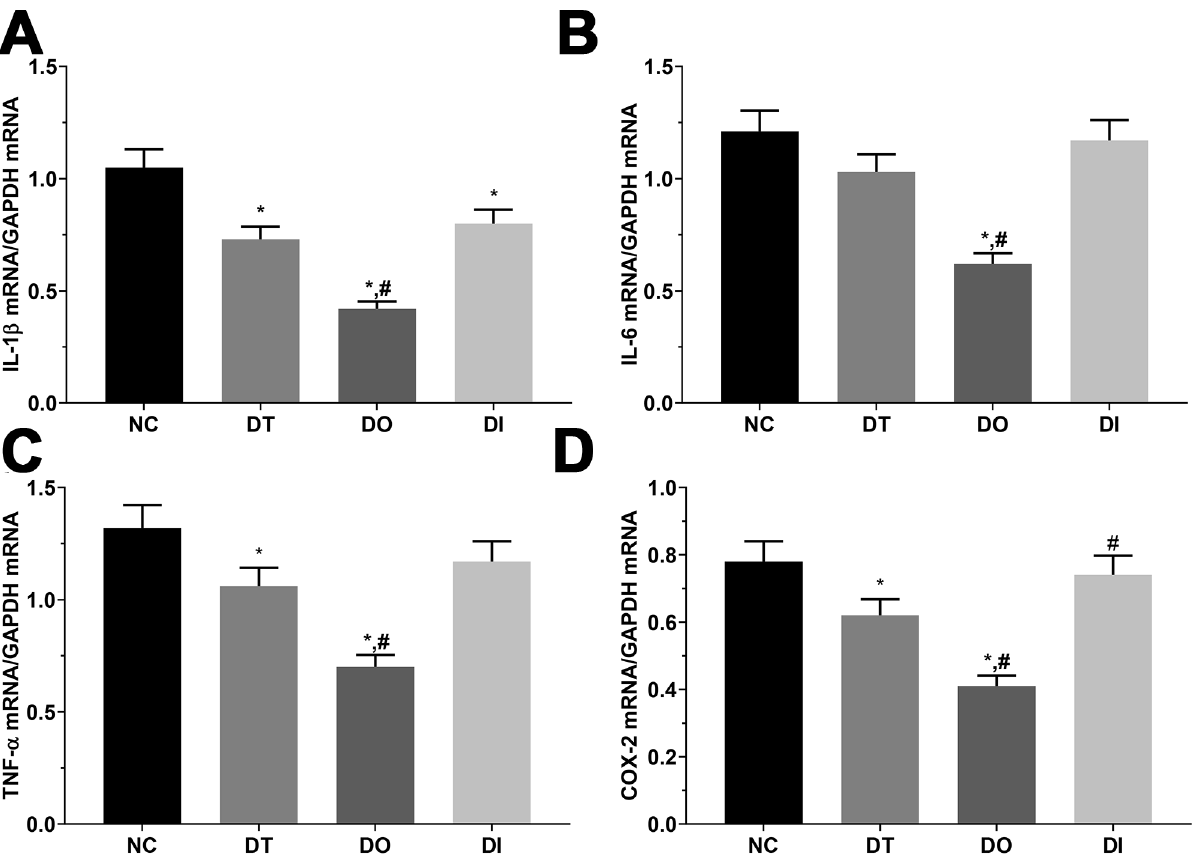
Figure 3 – Detection of pro-inflammatory factors in glial cells. (A) Expression of IL-1b mRNA in NC, DT, DO and DI group of glial cells. (B) Expression of IL-6 mRNA in NC, DT, DO and DI group of glial cells. (C) Expression of TNF-A in NC, DT, DO and DI group of glial cells. (D) Expression of PTGS2 in NC, DT, DO and DI group of glial cells. Data was presented as mean ± SD, each experiment was repeated for three times. *P<0.05 vs NC group of cells. #P<0.05 vs signal dezocine treatment group. NC: normal group, DT: dezocine treatment group, DO: dezocine treatment combined with RAPGEF3 overexpression group, DI: dezocine treatment combined with RAPGEF3 inhibition group. SH: sham group, TD: dezocine treatment group, TO: dezocine treatment combined with RAPGEF3 overexpression group, TI: dezocine treatment combined with RAPGEF3 inhibition group.